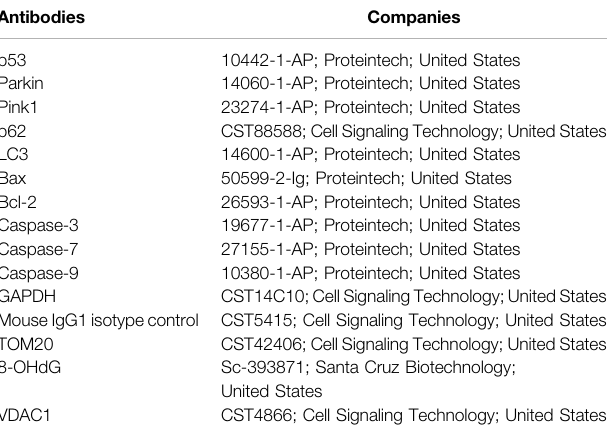
TABLE 1 | The antibodies used in this